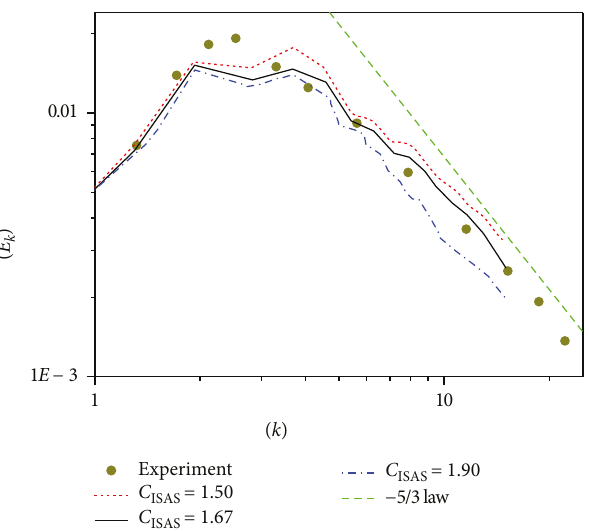
Figure 1: Comparison of energy spectra between ISAS simulations and DHIT